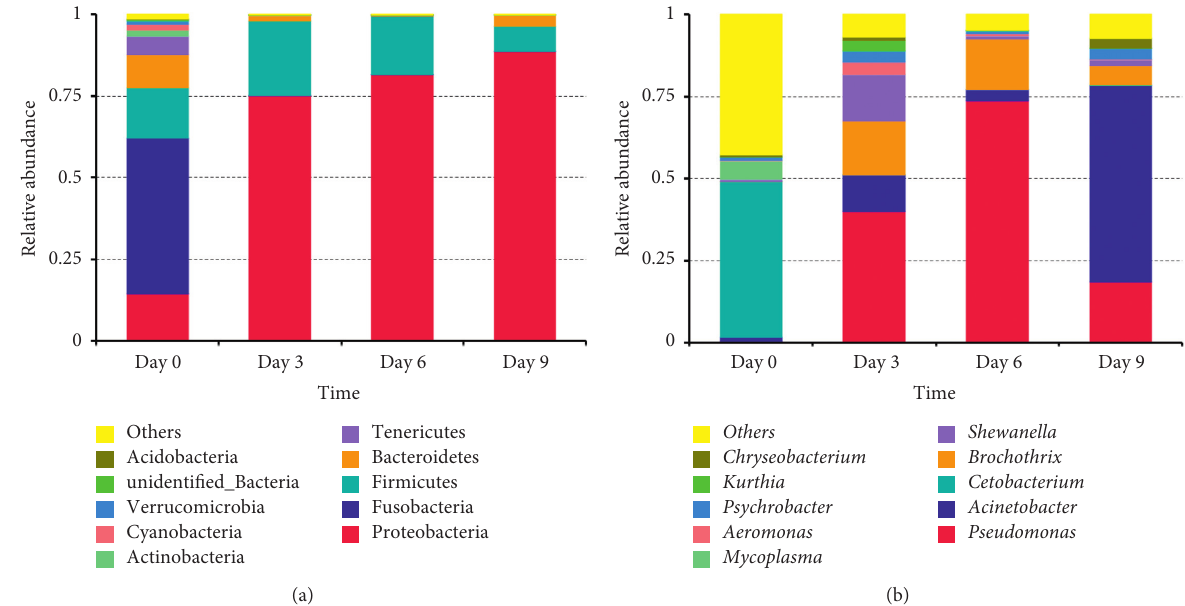
Figure 3: Relative abundance of spoilage microbiota during rainbow trout storage at 4 ° C. (a) The phylum level; (b) the genus